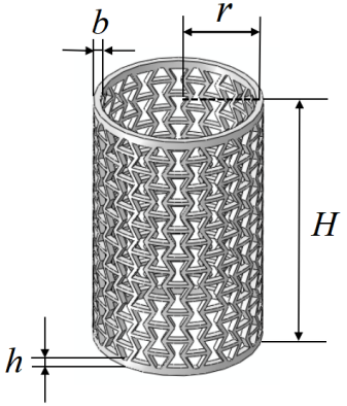
Figure 5. Geometrical configuration of RHCS. Table 1. The geometrical dimensions of RHCSs.